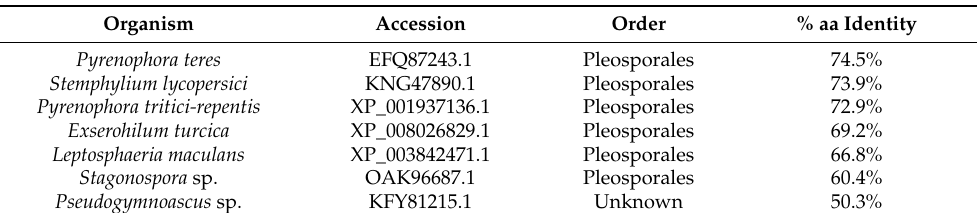
Table 6. Percent amino acid (aa) identity of pblast results of PKS 39849 sequence. Fungal order within the class Dothideomycetes.